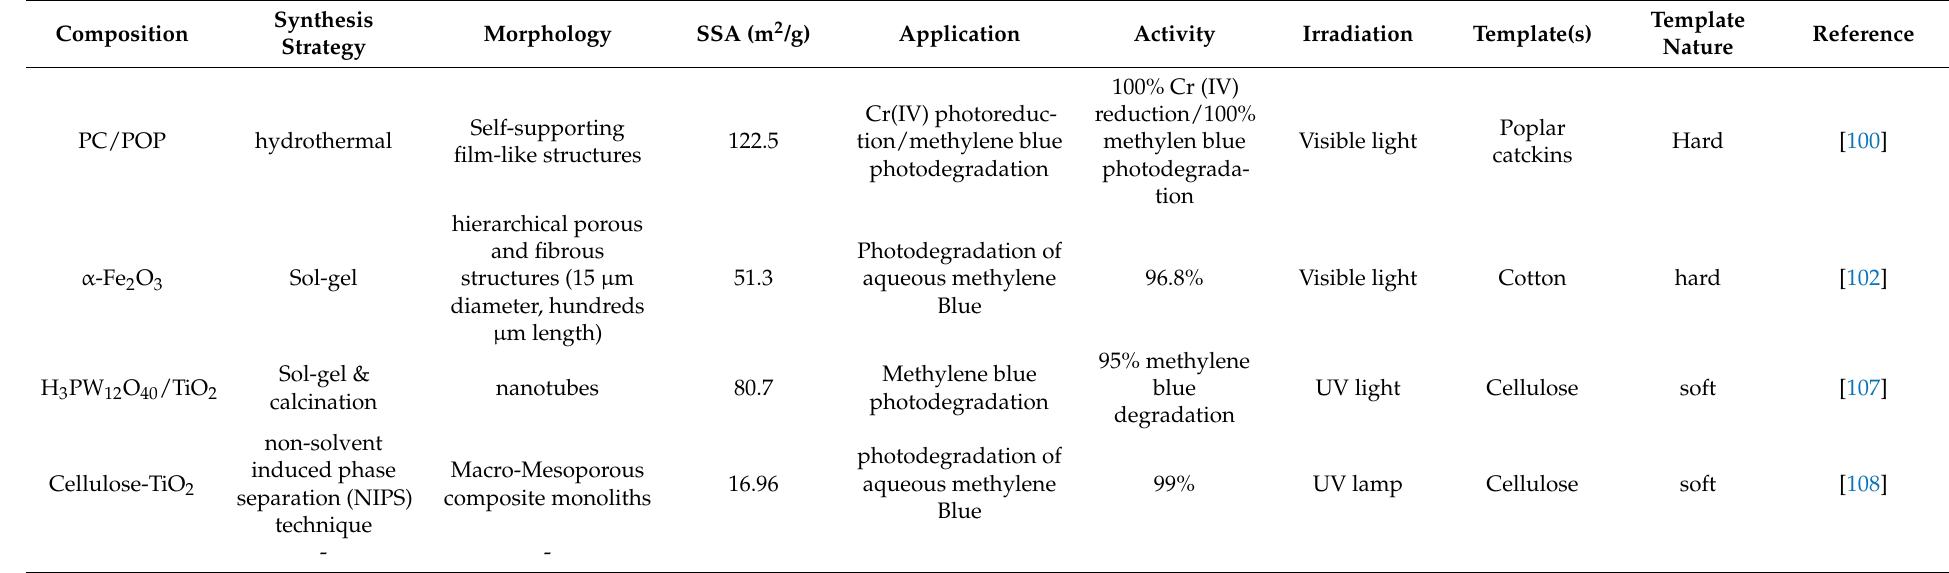
Table 3. Hierarchical catalysts produced by using bioavailable templates